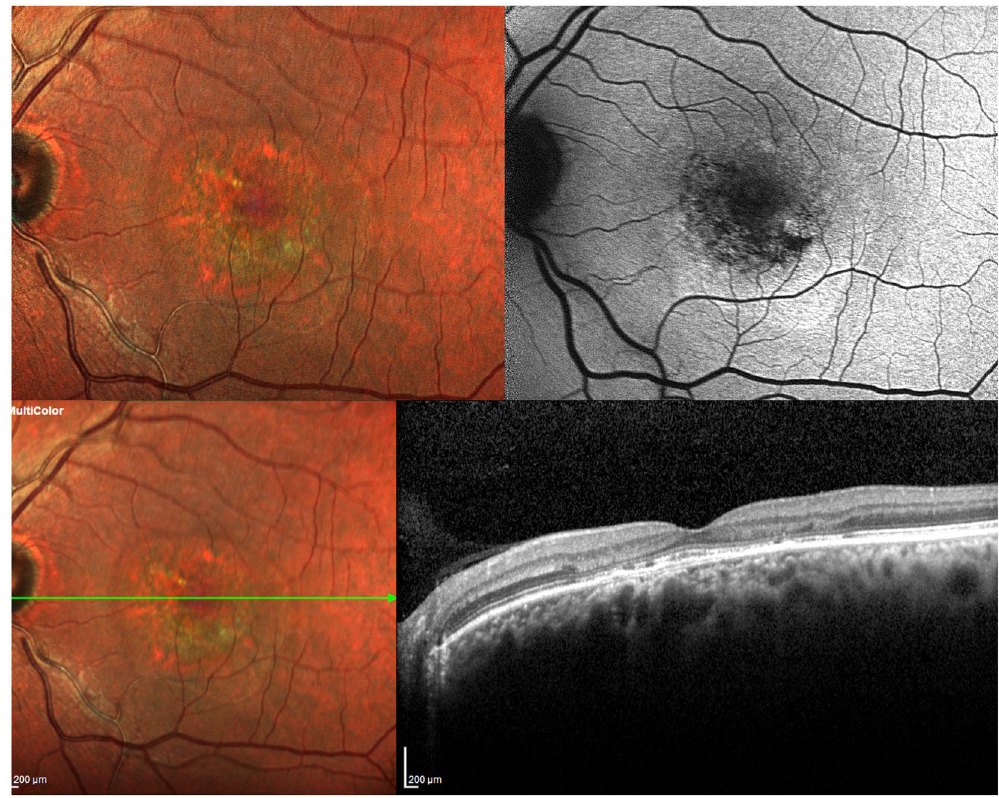
Figure 2. Resolved neurosensory detachment (NSD) on multicolour imaging (MCI) and fundus autofluorescence (FAF) - Left eye MCI (top left) shows an area of altered reflectivity with subretinal deposits and retinal pigment epithelium (RPE) atrophy within while the corresponding FAF (top right) depicts an a ring of hyper-autofluorescence surrounding a inner ring of stippled autofluorescence with a few foci of hypoautofluorescnce. The corresponding spectral domain optical coherence tomography (SD-OCT) at the bottom shows absence of NSD along with outer retinal disruption, altered RPE reflectance and a double-layer sign. This depiction of NSD on MCI and FAF are important in understanding the disease history and the corresponding functional